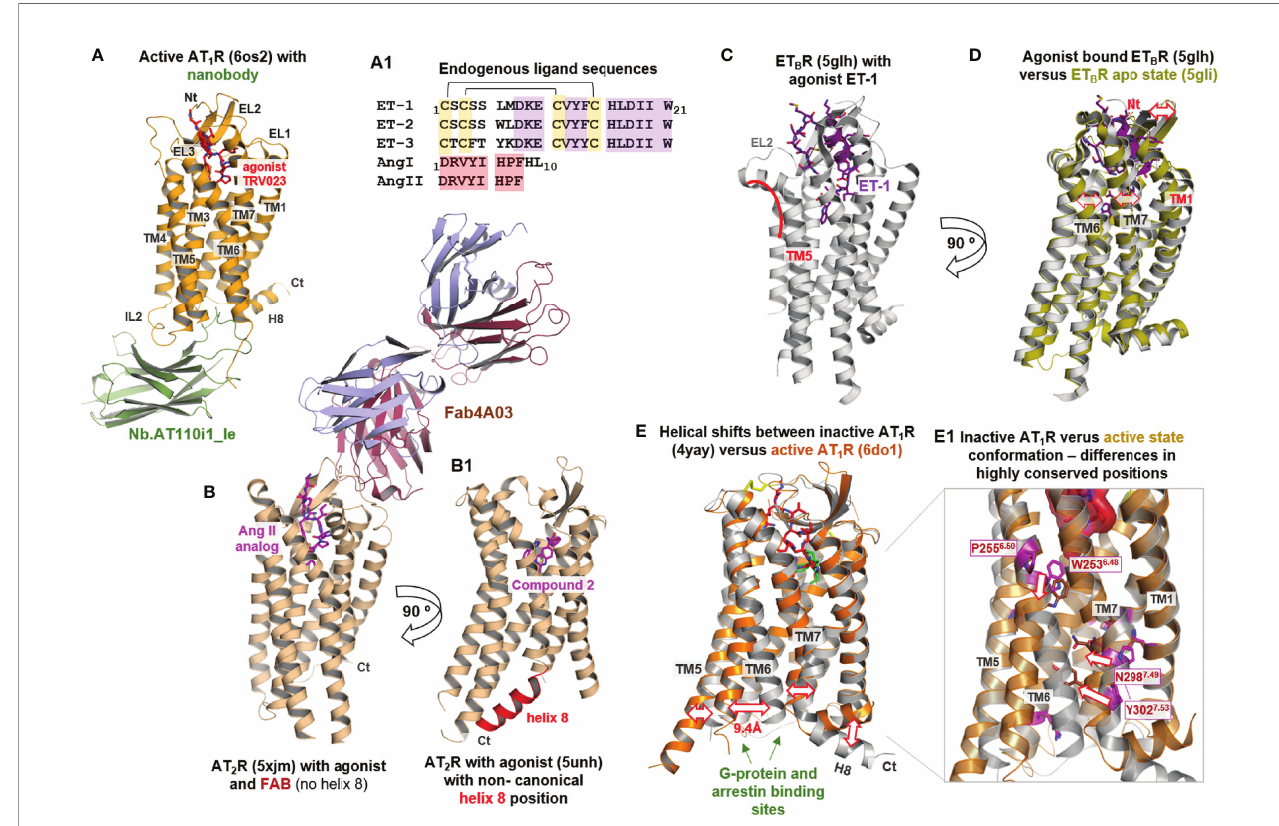
FIGURE 4 | Agonist-bound and apo-state conformations of ATRs and ET B R. (A) Diverse AT 1 R structures in the agonist-bound state are already available ( Table 1 ). The agonist [endogenous peptide agonist sequences are provided in (A1) , including annotated disul fi de bridges and conserved regions (colored background)] is bound extracellularly between the ELs and their transitions to the helices ( Figure 5 ). Several AT 1 R structures are stabilized intracellularly by a bound nanobody ( Table 1 ). The agonist-bound structures are not complexed yet with G-protein or arrestin. (B) The AT 2 R structures not only contain various agonists but have been further stabilized in some cases with Fabs (fragment antigen binding), which bind on the extracellular side. (B1) For AT 2 R, intracellular helix 8 has been observed to be directed inward to the transmembrane helix core and stabilizes the active state structure instead of a transducer protein like the G-protein. Generally, helix 8 is oriented parallel to the membrane and outside the helical bundle in GPCRs. (C) The active state ET B R structure bound with ET-1 represents endogenous ligand binding, whereby the ligand is buried deep within the ligand-binding pocket (see Figure 5 ). The helical transition from EL2 to TM5 is kinked (red line) in contrast to the ATR structures. (D) Comparison with the ligand-free apo-state conformation highlights structural differences in the extracellular region where the ligand is bound, mainly in TM6 and TM7, but also for EL2 (red arrows). A further difference is the helical transition between the N- terminus and helix 1 in the apo-state structure compared to an unfolded transition in the ligand-bound structure. (E) Agonist-bound AT 1 R and AT 2 R receptor conformations deviate from the inactive state structures in the intracellular orientation of TM6, but also relative spatial shifts are observed at the intracellular parts of TM5 and TM7 (red arrows). For the AT 1 R, strong deviations in the H8 orientation are observable in dependency of the activity state. (E1) The structural transitions between inactive and active state conformations are accompanied by re-organization of intramolecular interactions in the transmembrane helical core (62), as visualized here exemplarily at amino acid residues in TM6 and TM7. This re-organization and subsequent new interactions are involved in maintaining active state-like